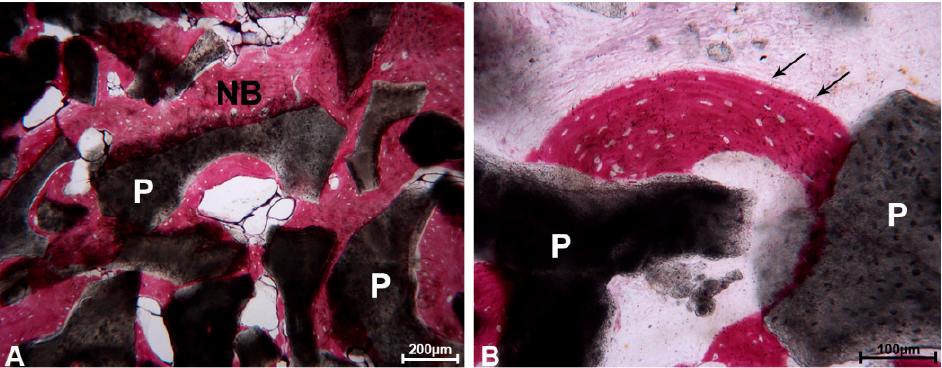
Figure 6. AAB. ( A ) Residual biomaterial particles (P) were encircled by a bridge-like network of newly formed bone (NB). Toluidine blue and acid fuchsin, original magnification 40×. ( B ) At higher magnification, a bridge-like network of newly formed bone (black arrows) between the particles (P) was present. Toluidine blue and acid fuchsin, original magnification 100×.